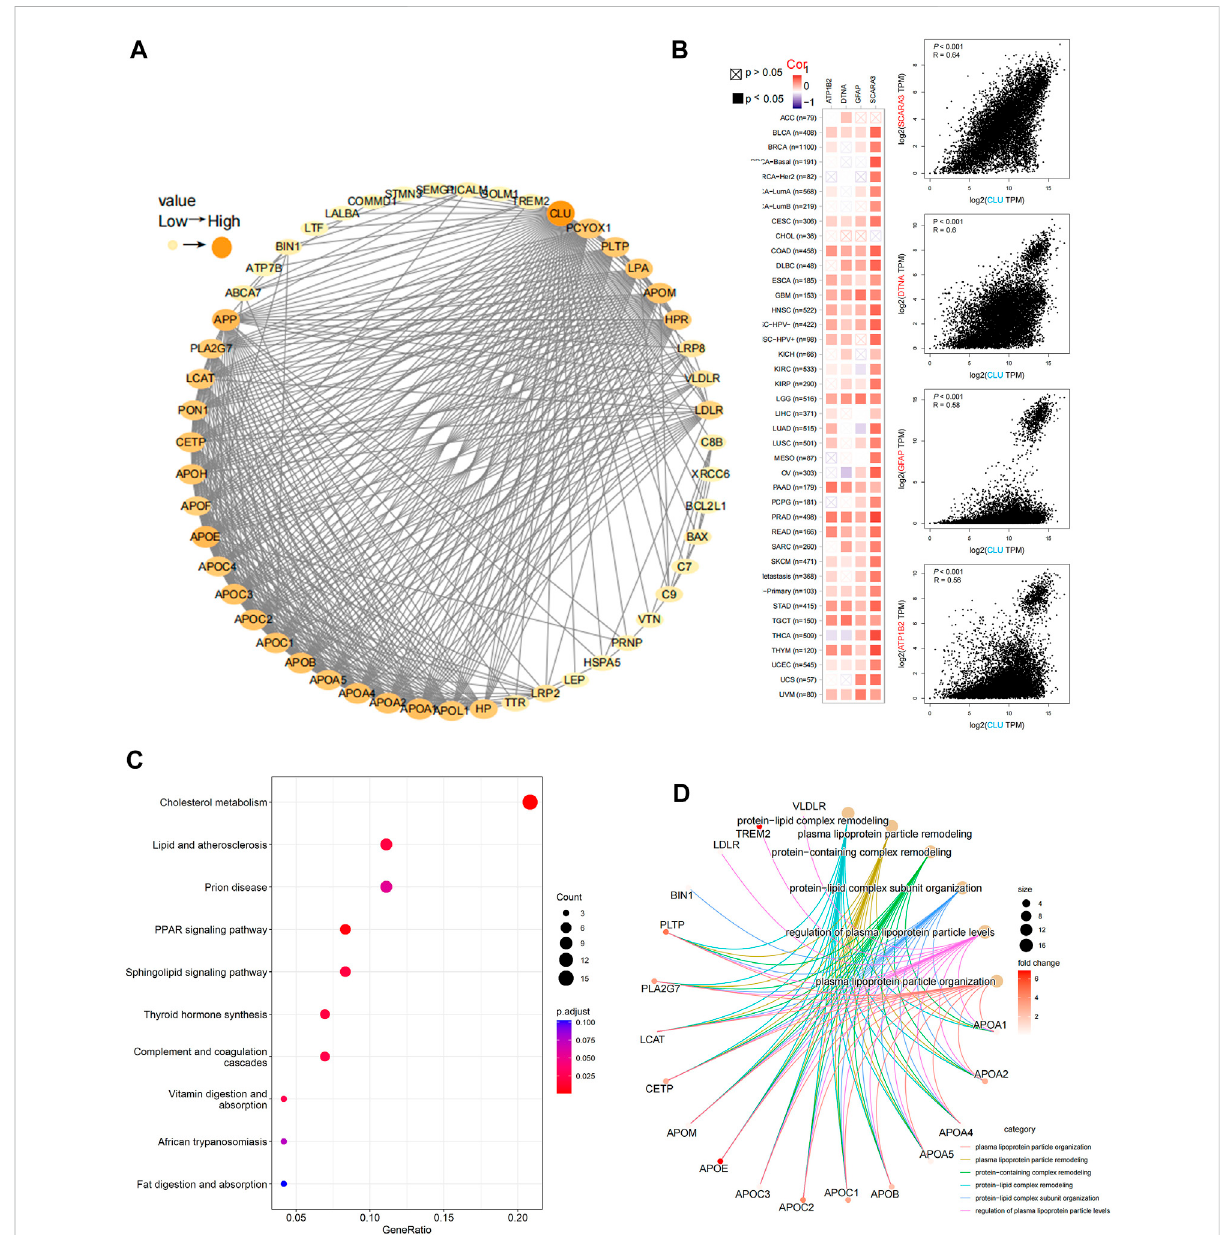
FIGURE 7 Analysis of CLU-related gene enrichment. (A) The top 50 CLU -bound proteins were identi fi ed experimentally using STRING program and depicted using a molecular interaction network; (B) utilizing GEPIA2 tool, the top 100 CLU -related genes in TCGA projects were collected, and the expression correlation among CLU and the top four targeted genes (SCARA3, DTNA, GFAP, and APT1B2) was examined, the matching heatmap data for the cancer types selected are presented; (C) analysis of KEGG pathways related to CLU -bound and interacting genes; (D) Gene Ontology (GO) study of CLU -bound and interacting